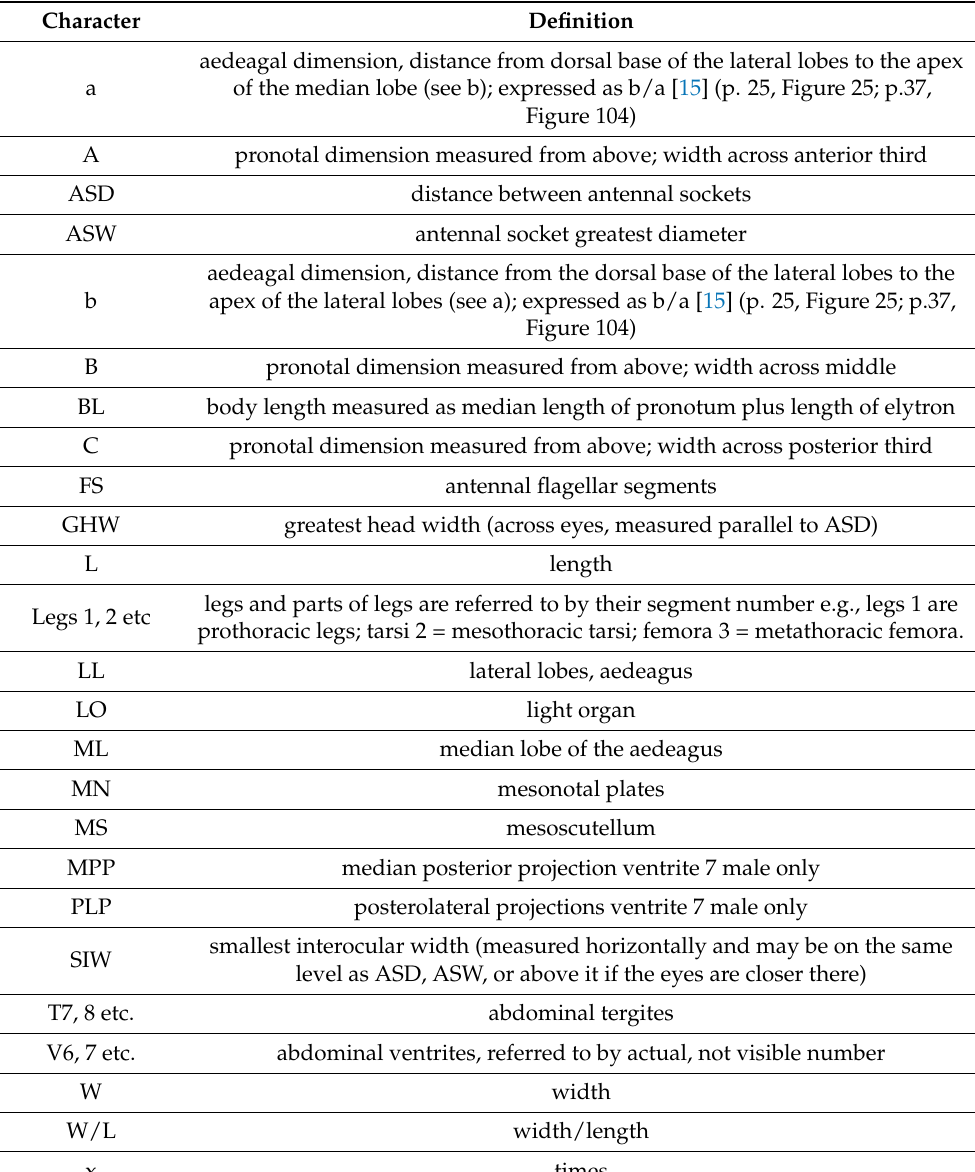
Table 1. Abbreviations and definitions of morphological characters examined in this